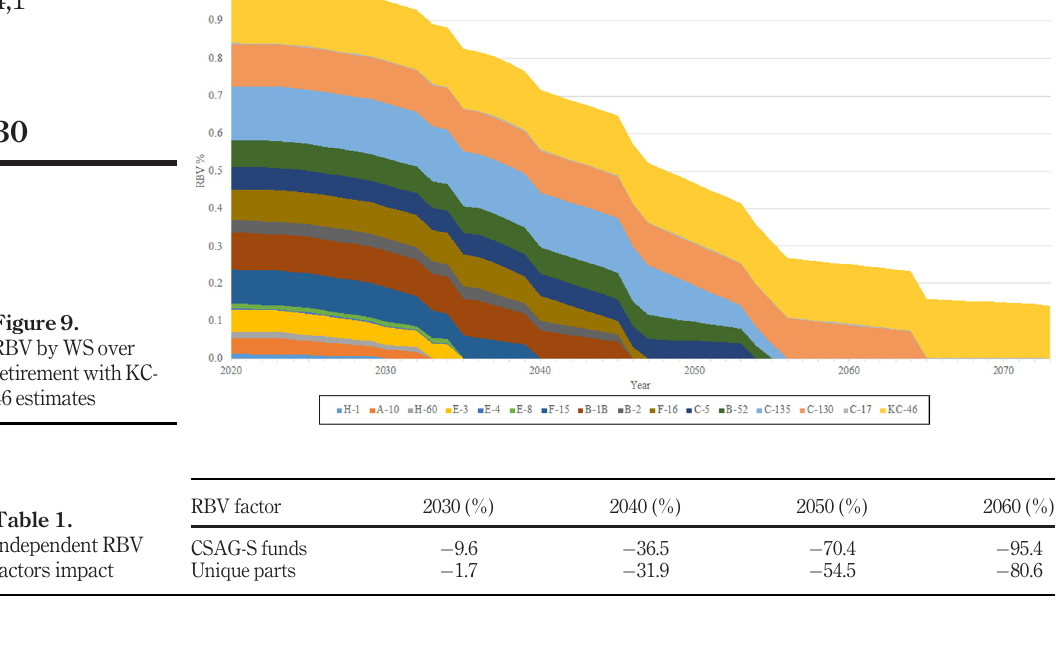
Table 2. Organic supply